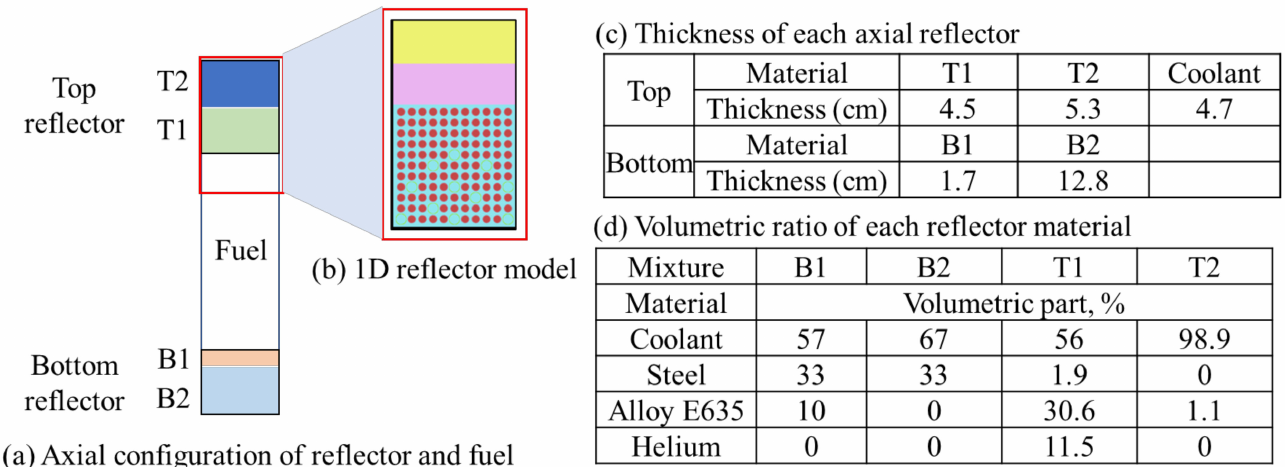
Figure 8. Composition of axial reflectors.